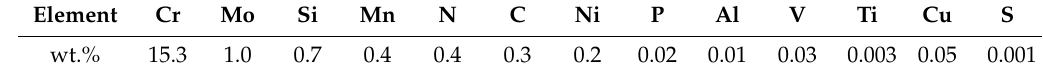
Table 1. Chemical composition as provided by the manufacturer.